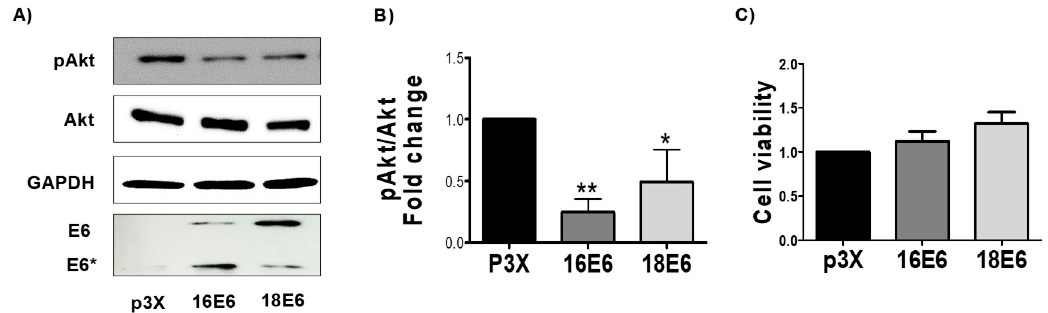
Figure 1. 16E6 and 18E6 oncoproteins decrease pAkt without changing cell viability in FaDu cells. FaDu cells were transfected with p3X, HPV16 E6- or HPV18 E6-expressing plasmids and were seeded in a 96 well plate. ( A ) Representative immunoblot; and ( B ) quantitative densitometry showing Flag-tagged E6 and E6* (E6 spliced product), protein kinase B (Akt) phosphorylated in serine 473 (pAkt) and total Akt. Glyceraldehyde 3-phosphate dehydrogenase (GAPDH) was used as a loading control. Human papillomavirus (HPV) E6 oncoproteins reduce pAkt. ( C ) Cell viability was quantified after 48 h by 3-(4,5-dimethylthiazol-2-yl)-5-(3-carboxymethoxyphenyl)-2-(4-sulfophenyl)-2H-tetrazolium (MTS) reduction and expressed as fold change in relation to the control. Data are expressed as the mean ± SD. Tukey’s test * p < 0.05 and ** p < 0.005 vs. p3X control, n = 3.